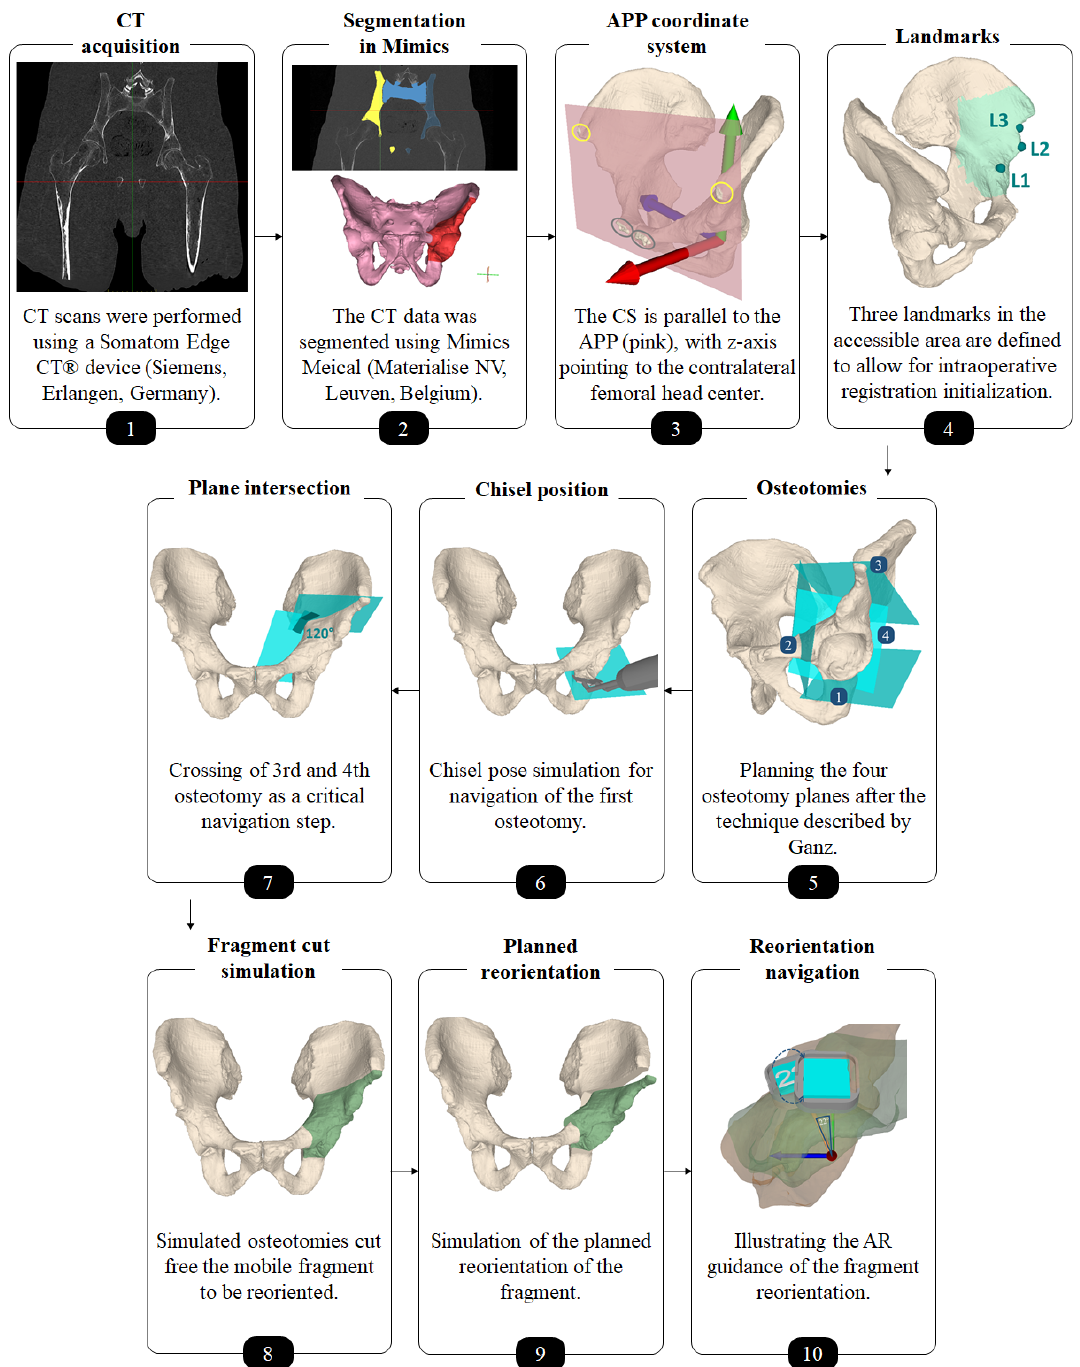
Figure 2. Overview of the preoperative planning